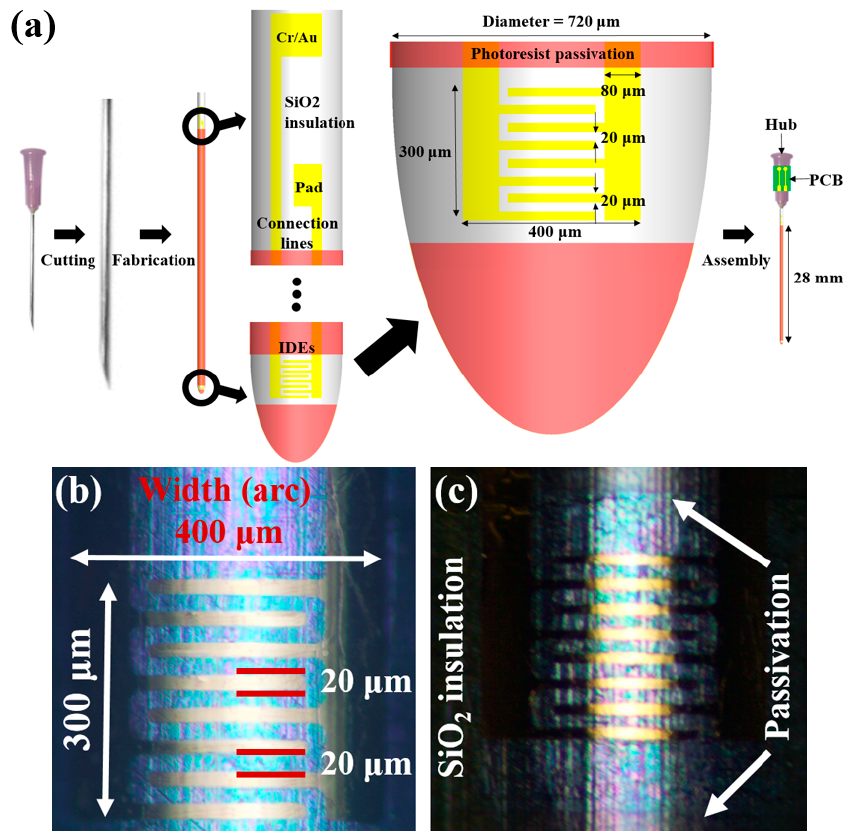
Figure 1. ( a ) Schematic design of the µ EoN-DP (micro electrical impedance spectroscopy-on-a-needle for depth profiling); photo images of the fabricated IDEs on the curved surface of the needle; ( b ) overall length and width of the IDEs were 300 µ m and 400 µ m, respectively; both the width and gap of the IDEs were as small as 20 µ m; and ( c ) selective passivation layer (SPL) on the needle insulated by SiO 2